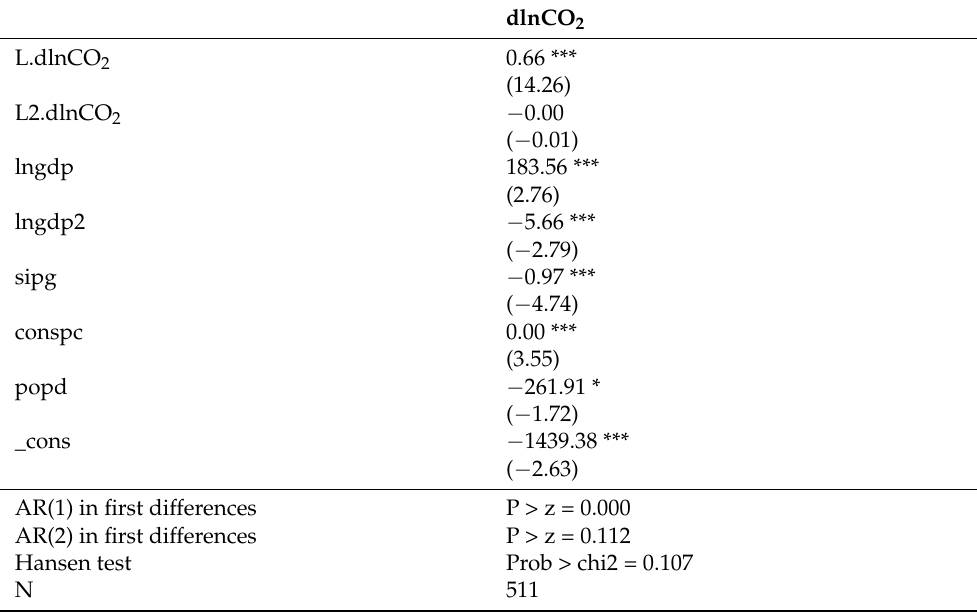
Table 8. Dynamic effect